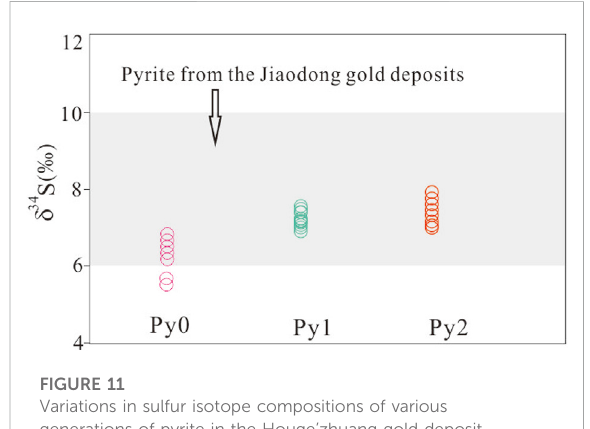
FIGURE 11 Variations in sulfur isotope compositions of various generations of pyrite in the Houge ’ zhuang gold deposit.